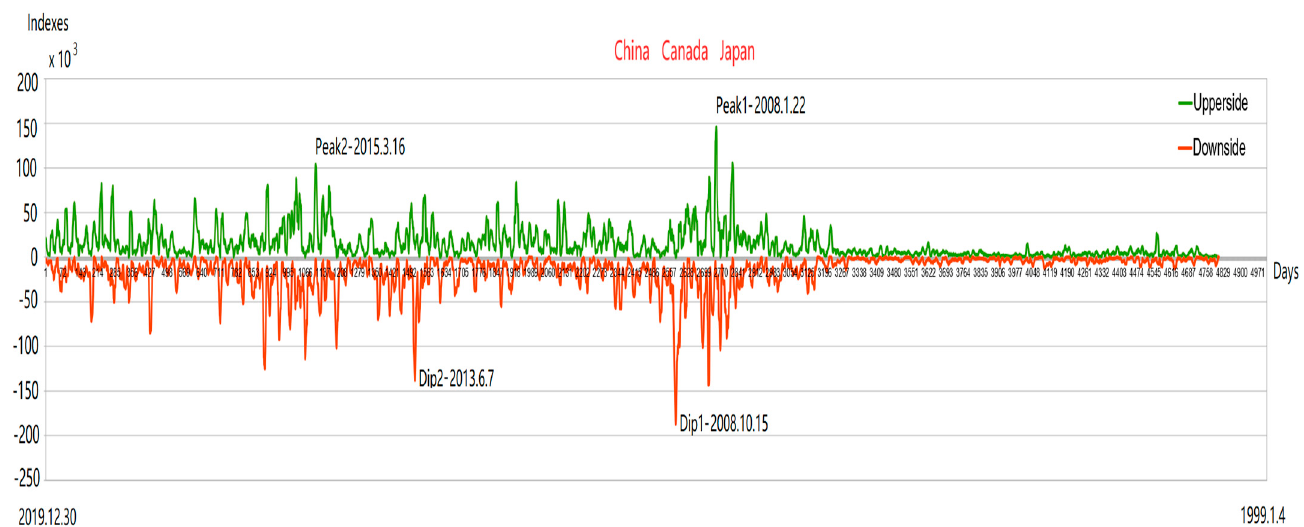
Figure 7. Semi-covariances between gold price and China, Canada, and Japan from the year 2019 back to 1999. Table 1. 2019–2009 and 2009–1999 years’ gold price in USD to stock index correlations.